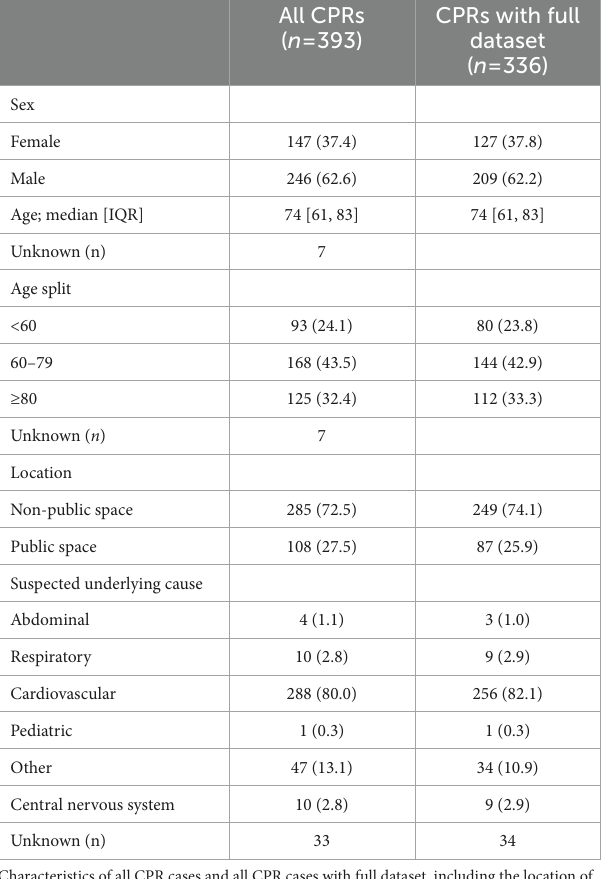
TABLE 1 Depiction of cardiopulmonary resuscitation (CPR) cases.